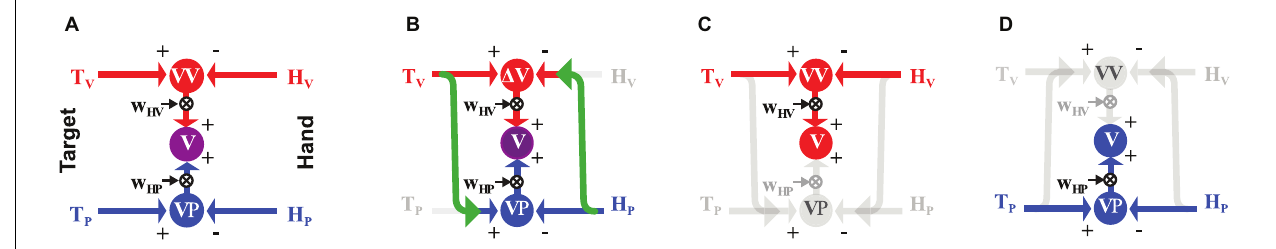
FIGURE 3 | Concurrent Model of multisensory integration. (A) Graphical representation of the sensory information flow when the target, T, to be reached (on the left) and the hand, H, used to perform the movement (on the right) can be both sensed through vision, V (red), and proprioception, P (blue). (cid:49) V and (cid:49) P represent the concurrent representations in the visual and proprioceptive space of the movement to be performed to reach the target. The weights W (cid:49) V and W (cid:49) P (see Equation 3) allow one to optimally combine the concurrent representations and maximize the precision of the final motor vector estimation ( (cid:49) ). (B) Application of the model to the cross-modal task of reaching a visual target with an unseen hand. Missing sensory cues are gray. The green arrows represent cross-modal transformations, that is, the encoding of an information coming from the visual system in the reference frame associated to the proprioceptive sensory system, V → P, or vice-versa, P → V. (C,D) Model application to uni-modal visual and proprioceptive tasks, respectively, where no cross-modal transformations are